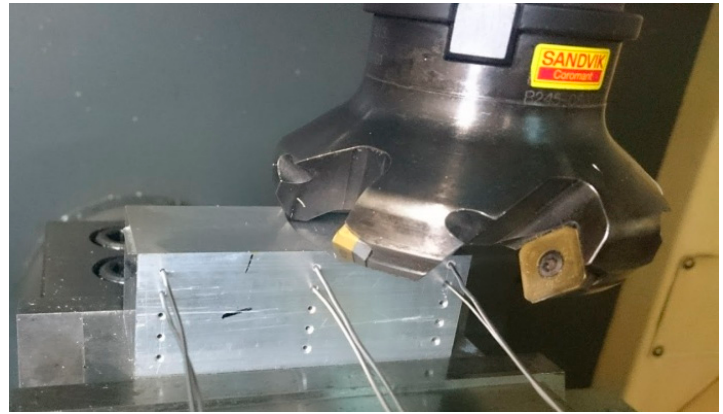
Figure 1. Experimental setup.